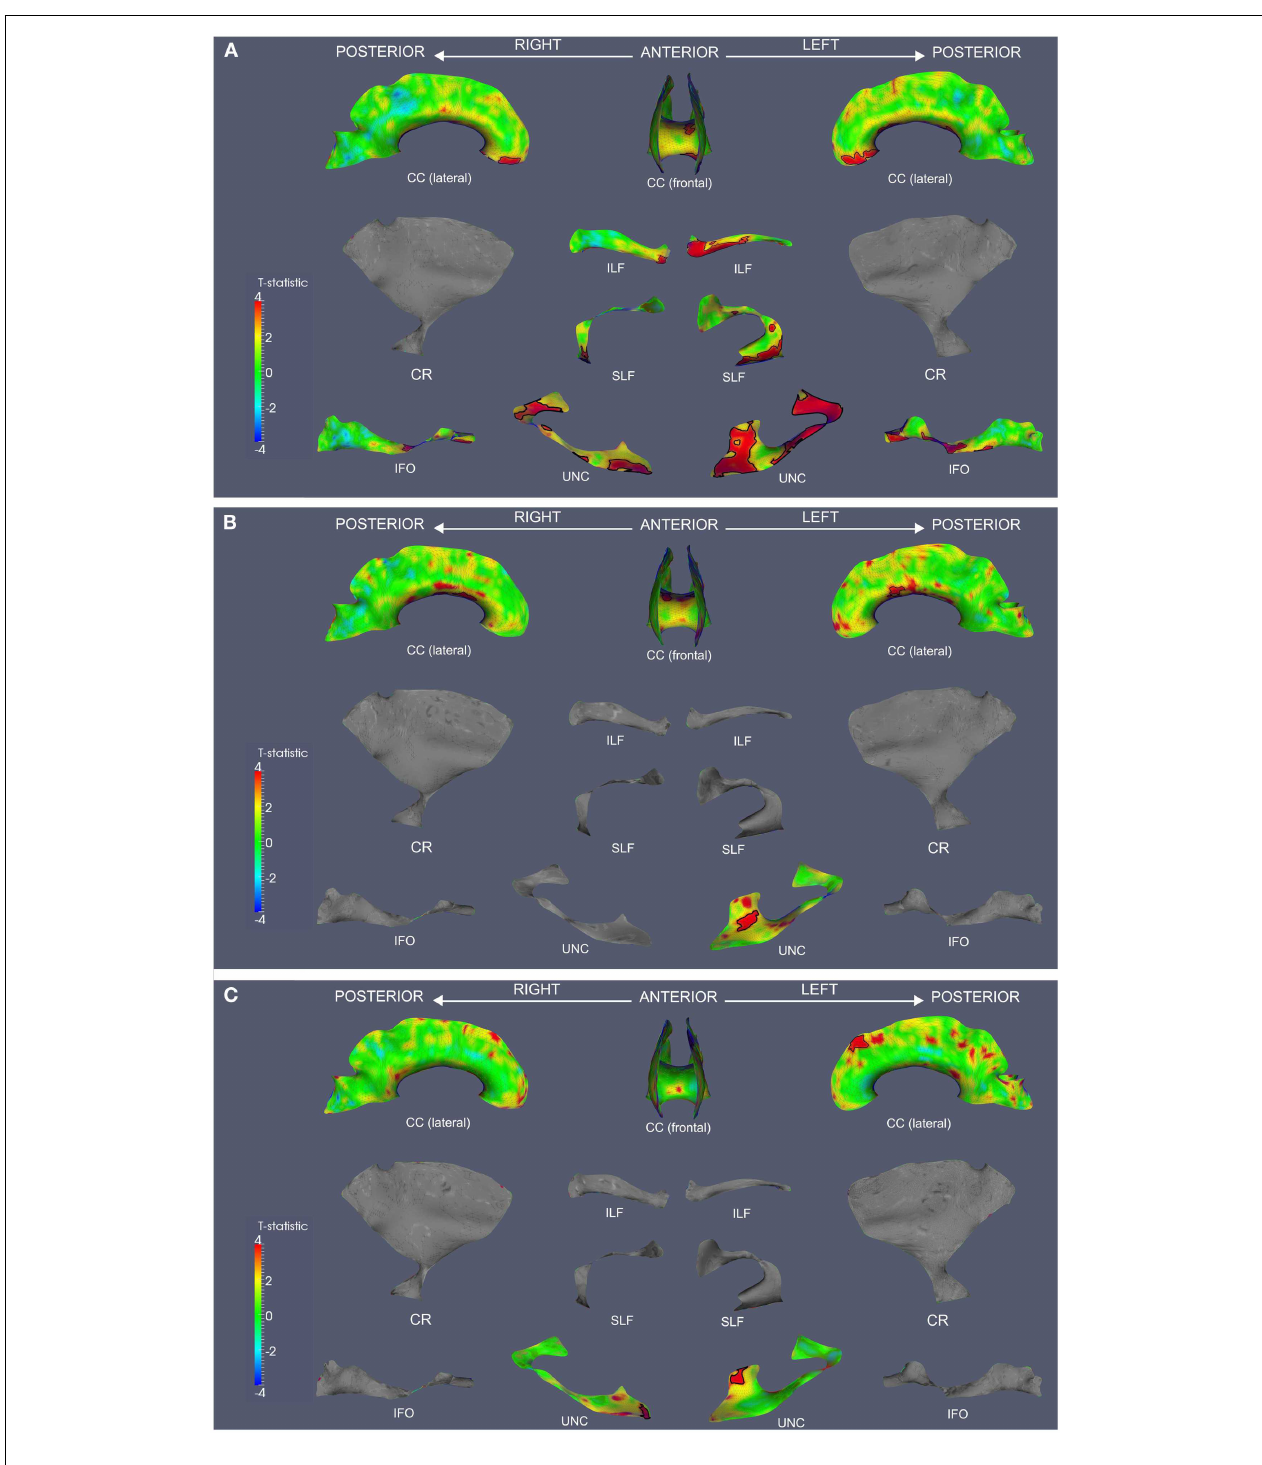
FA (C) . In all panels, red corresponds with higher t -values, and statistically significant clusters are outlined in black. CC, corpus callosum; CR, corona radiata; ILF, inferior longitudinal fasciculus; SLF, superior longitudinal fasciculus; IFO, inferior fronto-occipital fasciculus; UNC, uncinate